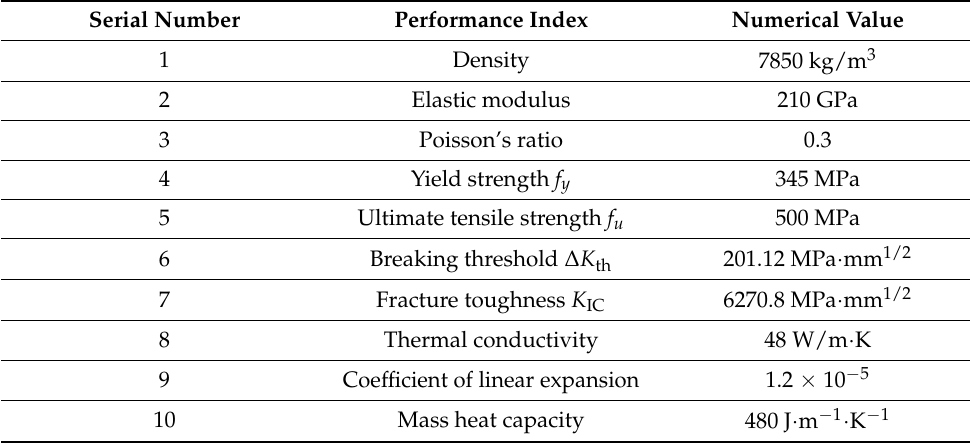
Table 2. Physical parameters of Q345D material.